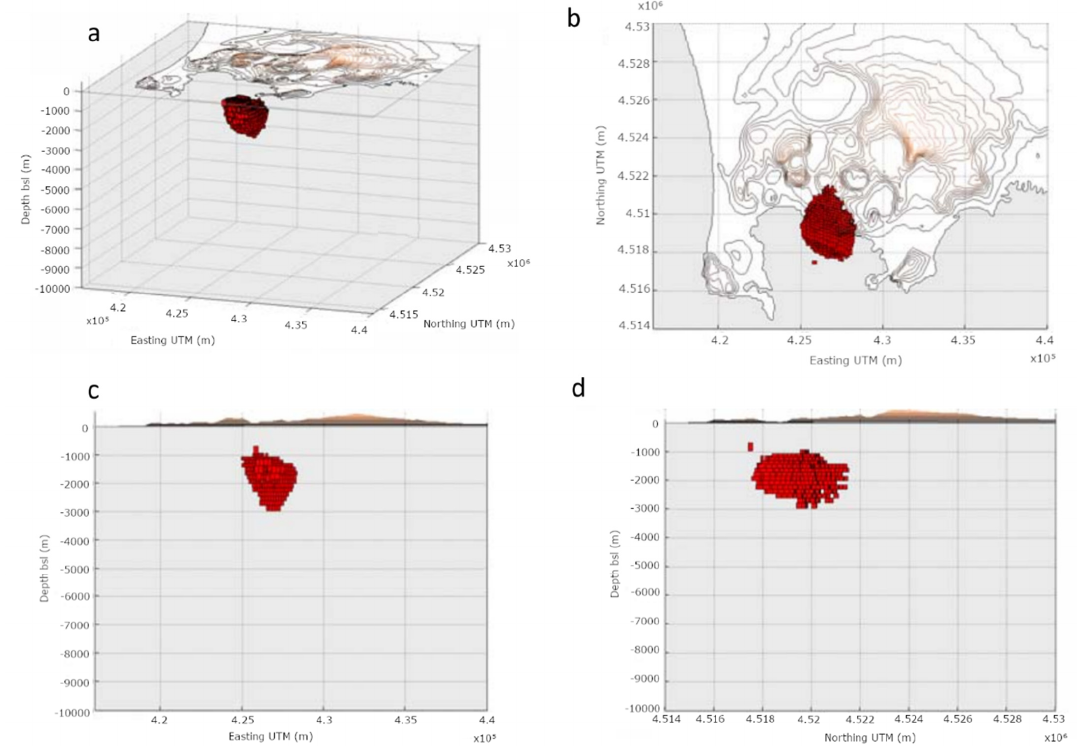
Figure 14. Source location, depth and shape for deflation period of 2007–2013. ( a ) 3D perspective; ( b ) map view of source below Campi Flegrei caldera; ( c ) EW vertical profile; ( d ) NS vertical profile